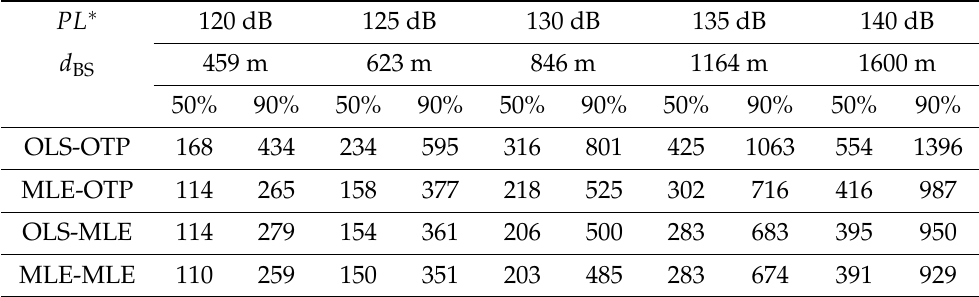
Table 5. Positioning error, in meters, 50th and 90th percentiles of Example 3 (2 GHz) with variable noise threshold level PL ∗ . Base stations have omni-directional ( N = 1) BS antennas and the average number of contacted BSs is N BS = 5.